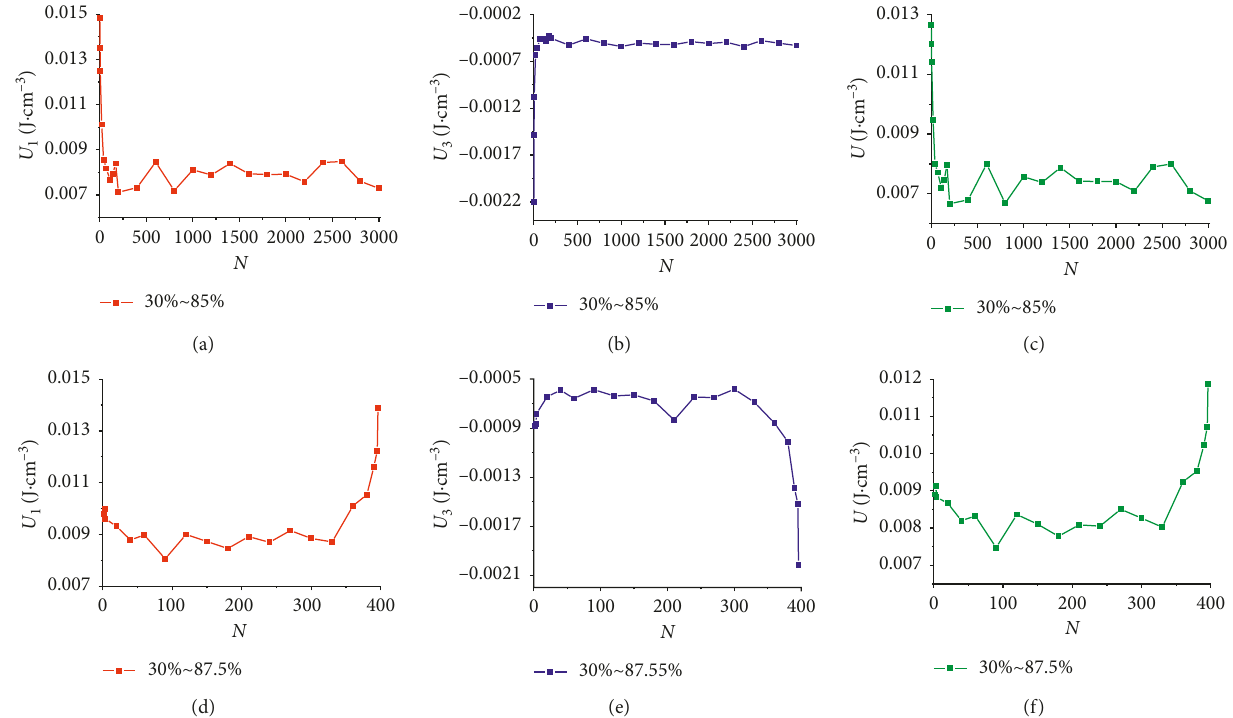
Figure 11: Dissipated energy versus loading cycle number curves at varying stress levels for limestone sample SA. 6: (a) axial, (b) cir- cumferential, and (c) total dissipated energies per unit volume at the first stress level and (d) axial, (e) circumferential, and (f) total dissipated energies per unit volume at the second stress level.